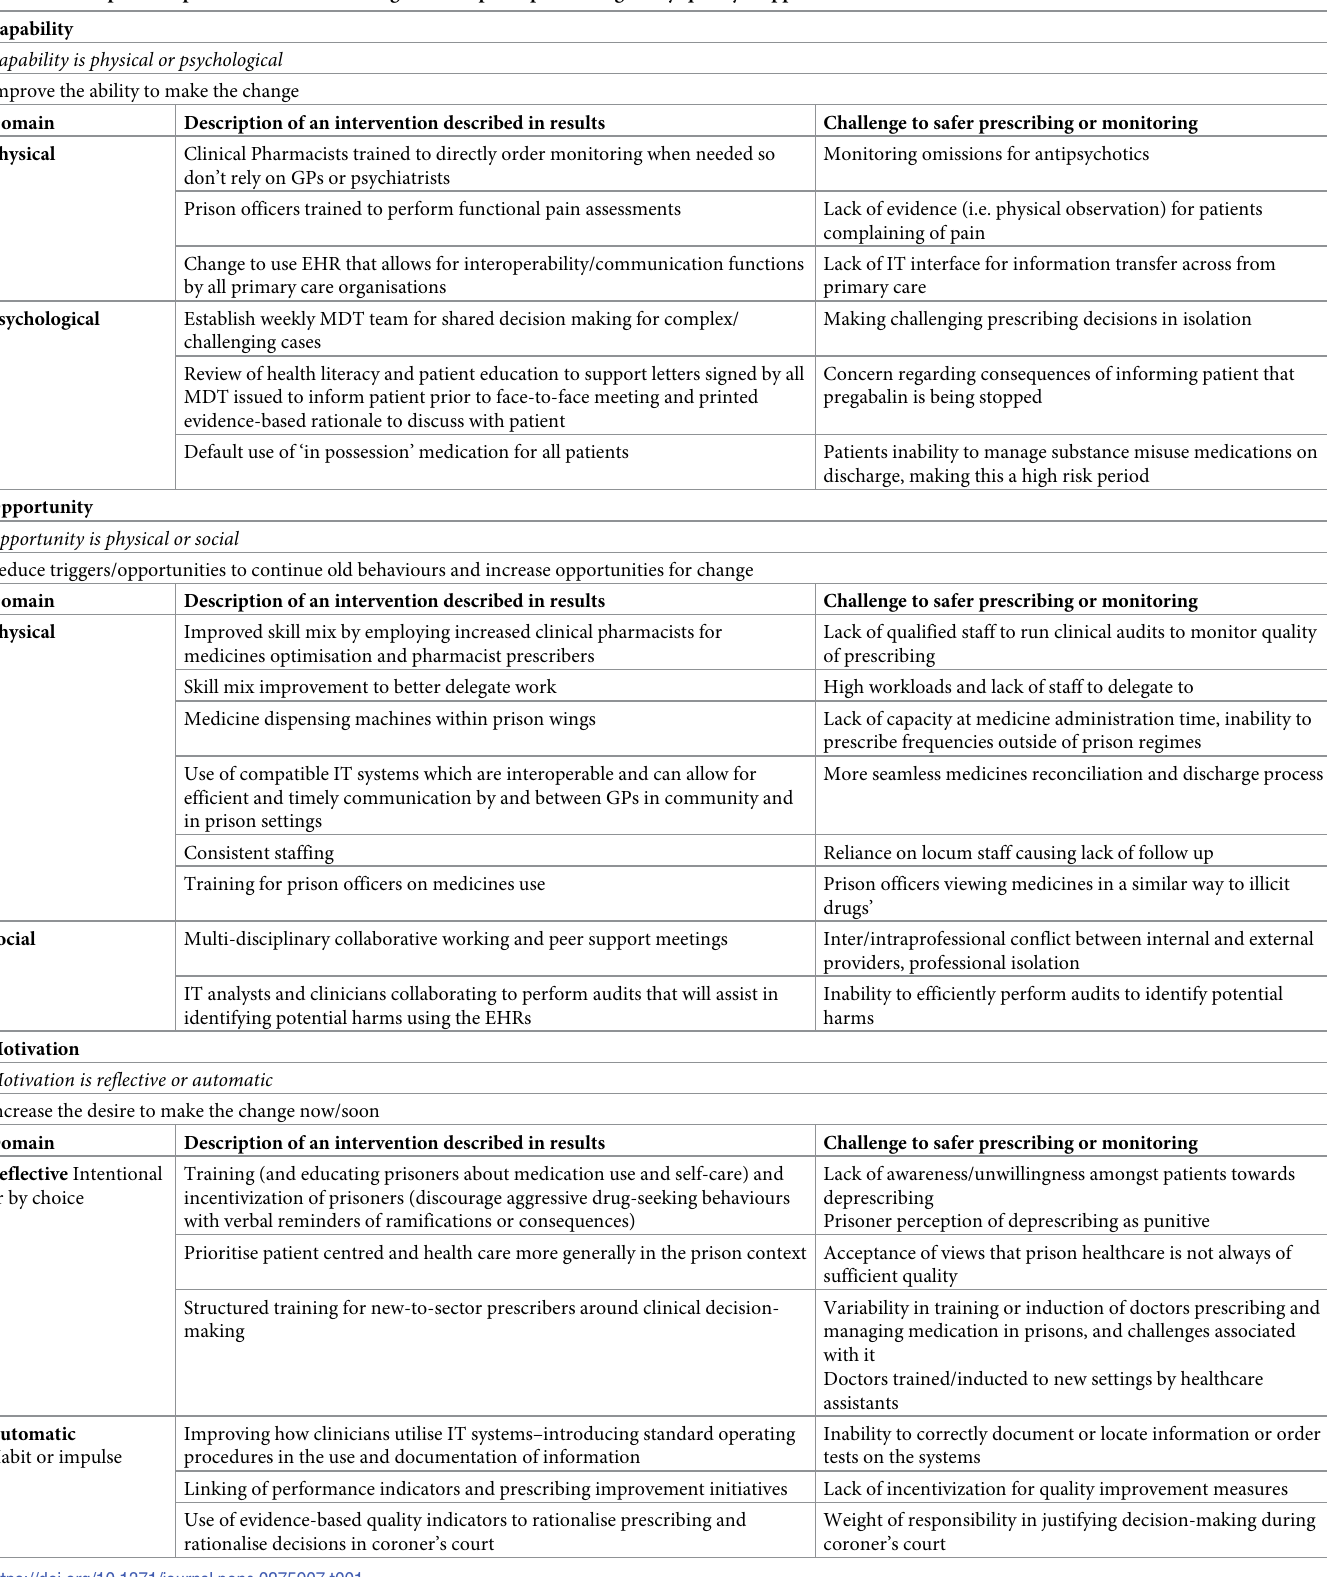
Table 1. Examples of reported interventions designed to improve prescribing safety/quality mapped onto